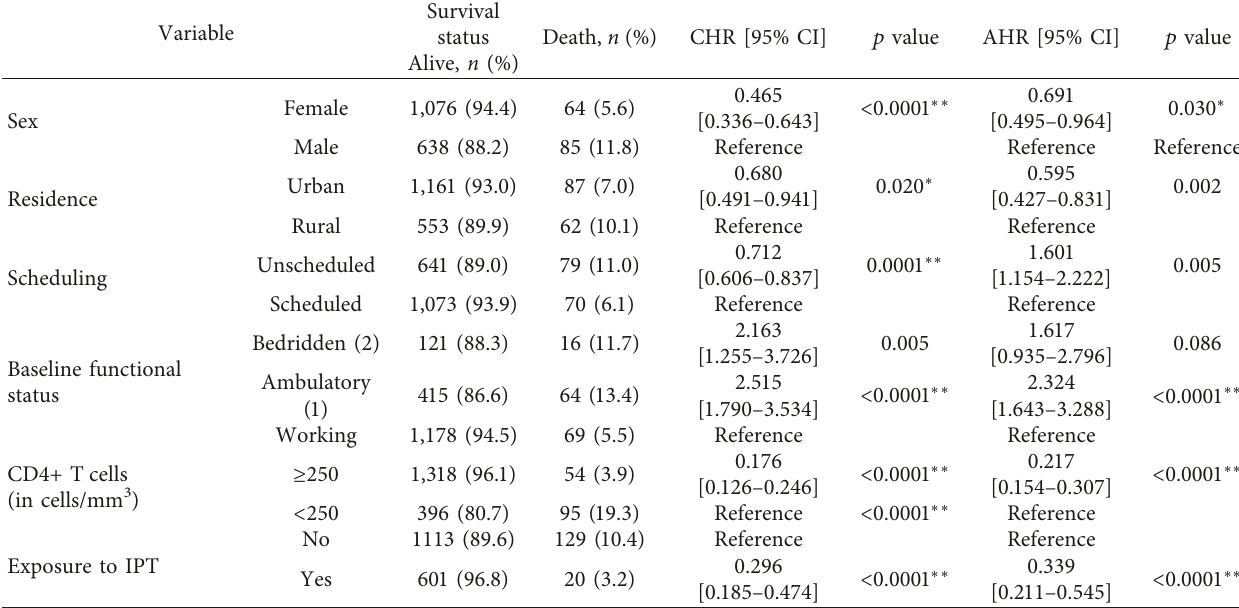
Figure 4: Kaplan–Meier survival analysis for patients living with HIV/AIDS taking IPTand ART versus ARTalone in Northern Ethiopia, 2009–2017. Table 4: Results of Cox regression analysis for factors associated with survival status among patients living with HIV/AIDS taking IPTand ART versus ART alone in Northern Ethiopia,